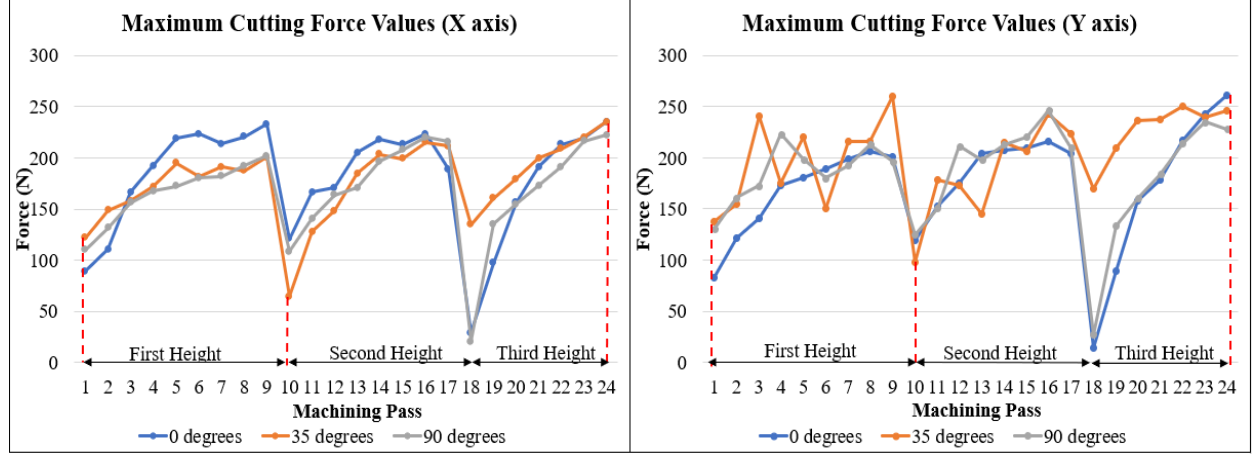
Figure 11. Maximum cutting force values for x ‐ and y ‐ axis.